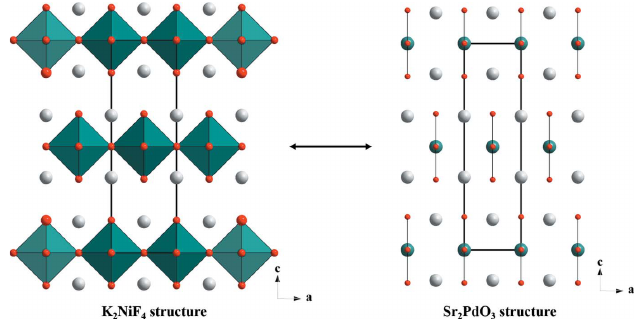
Figure 4 Interconversion of the Sr 2 PdO 3 and K 2 NiF 4